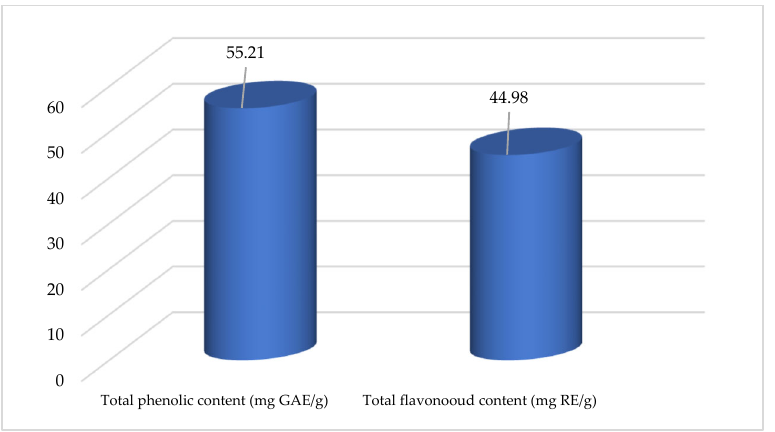
Figure 3. Total phenolics and flavonoids content in optimized chamomile extract